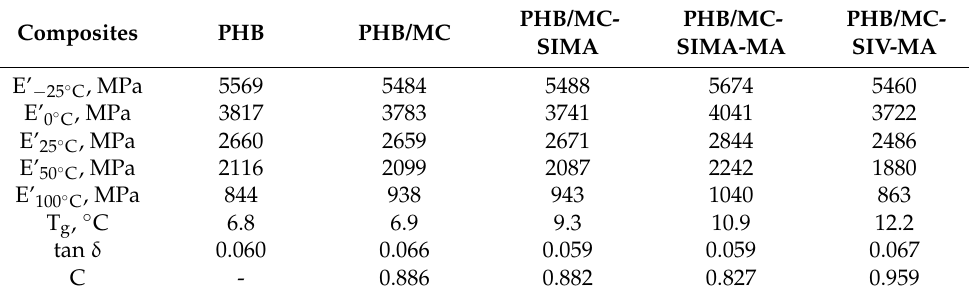
Figure 8. Storage modulus and tan δ of the composites vs. temperature. Table 4. Storage modulus (E’) of the composites at different temperatures, glass transition temperature (T g ) determined from tan δ vs. temperature curve and tan δ value at T g .